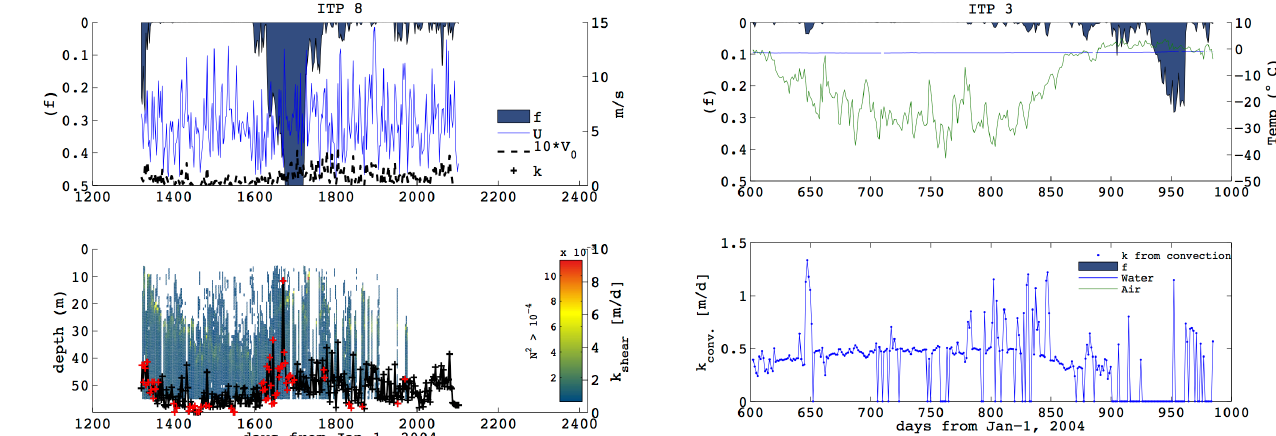
Figure 6. Top panel: Wind speed (U), ice velocity (V 0 ), and the fraction of open water (f), calculated along the drift path of ITP 8 (http://www.whoi.edu/itp). Bottom panel: The gas transfer velocity ( k shear ) that would result from shear-driven turbulence. Red “+” symbols indicate estimates of k shear that have been altered by stratification through the stability function (equation 11). The speckled color indicates the vertical distribution of N 2 > 10 -4 s -2 , giving a rough approximation of the mixed-layer depth. Some data gaps exist in the ITP profiles.